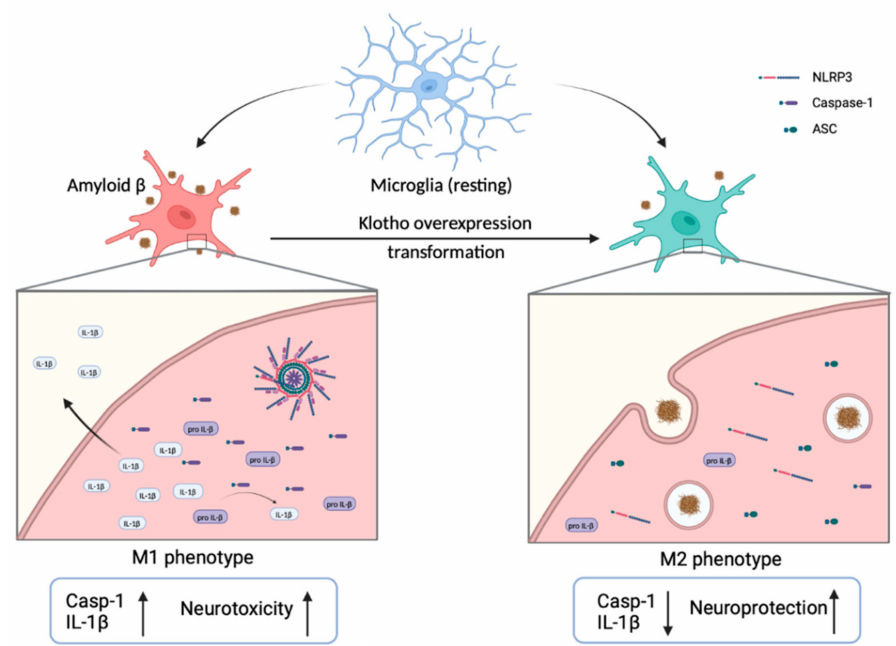
Figure 3. Transformation of microglia with the overexpression of Klotho. Microglia are usually in a resting state in the brain. Once activated, they show either M1 or M2 phenotypes. In the activated M1 phenotype, the expression of caspase-1 and IL-1 β is enhanced, which stimulate a pro-inflammatory response and cause neurotoxicity. In contrast, when Klotho is overexpressed, M1 microglia are differentiated into M2 microglia. The secretion of caspase-1 and IL-1 β is decreased, thereby facilitating A β clearance, preserving neurons and protecting against cognitive